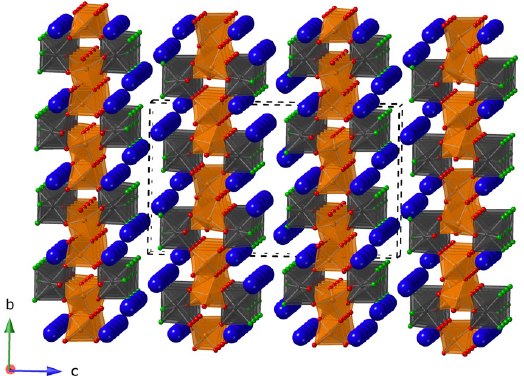
Figure 3. Representation of the single crystal structure of Rb 4 Ge 5 O 9 F 6 . Rubidium atoms are shown in blue, GeO 3 F 3 octahedra in grey, GeO 4 tetrahedra in orange, oxygen atoms in red, and fluorine atoms in green.